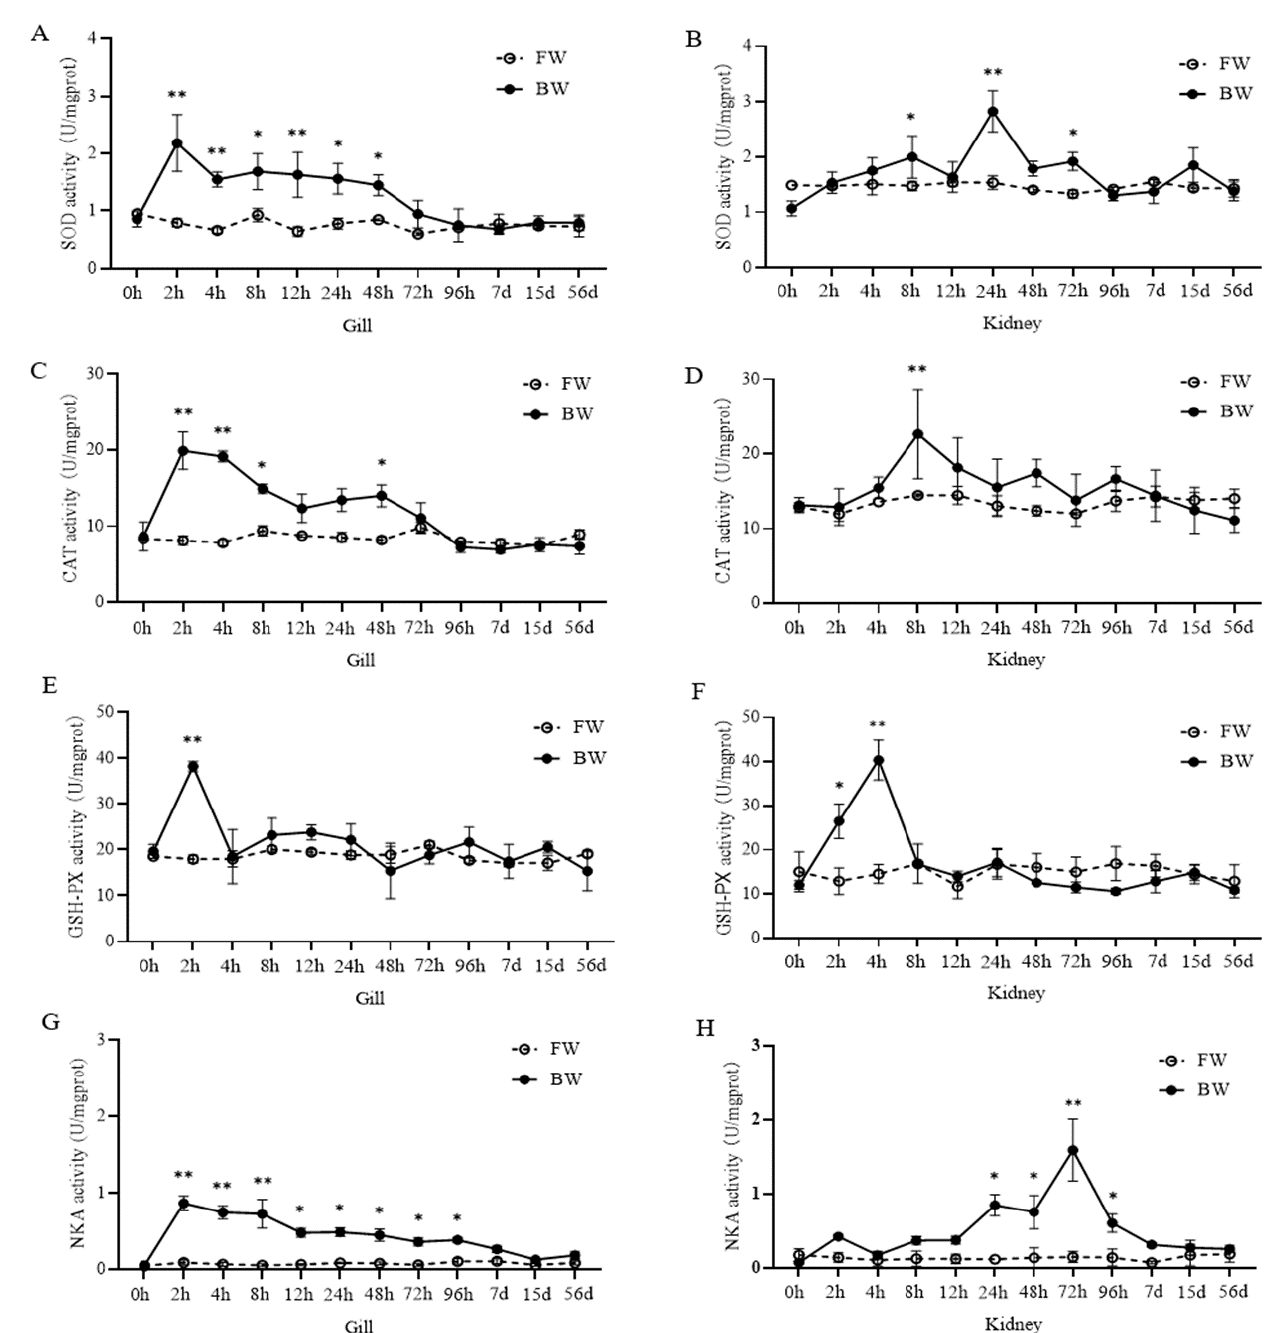
Figure 1. Effects of different salinities on activity of antioxidant enzymes in gill and kidney of silver carp. SOD activity in ( A ) gill and ( B ) kidney; CAT activity in ( C ) gill and ( D ) kidney; GSH-PX activity in ( E ) gill and ( F ) kidney; NKA activity in ( G ) gill and ( H ) kidney. Bars ± standard deviation (SD) with different letters are significantly different. * and ** indicate significance level of p < 0.05 and p < 0.01, respectively.